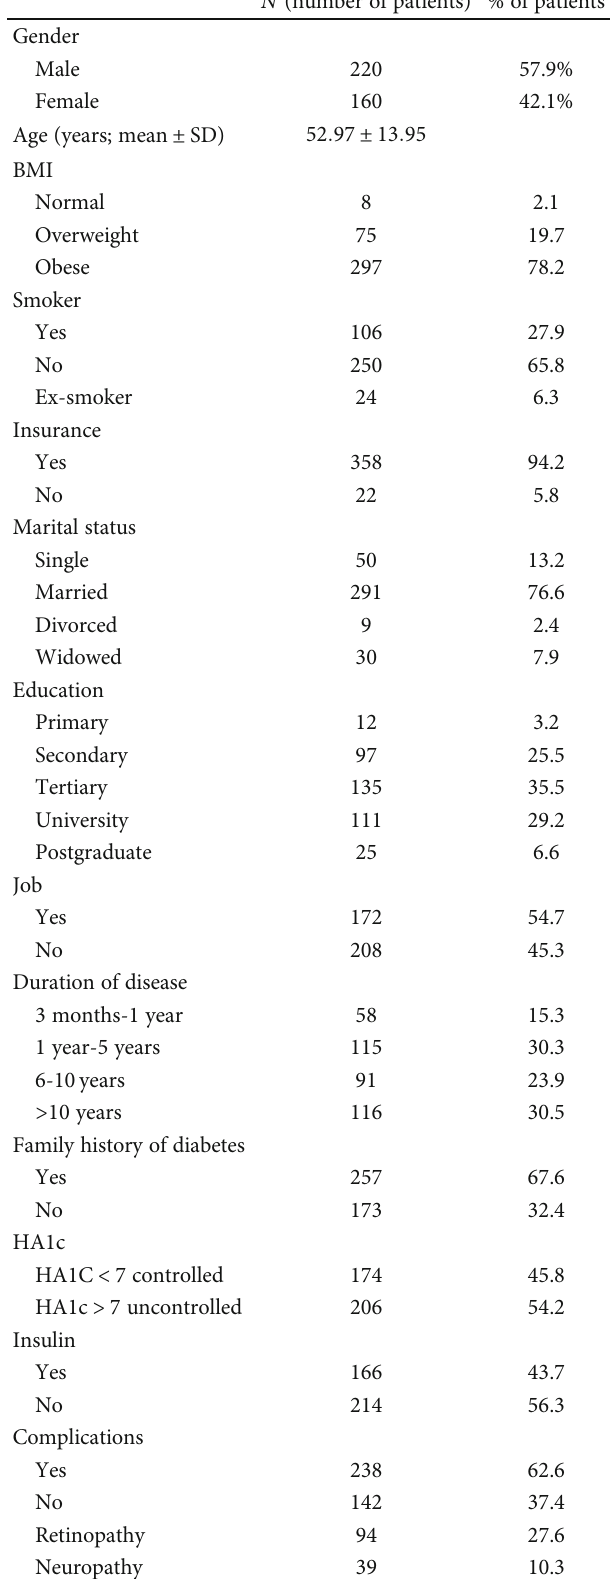
Table 1: Sociodemographic and clinical patient ’ s